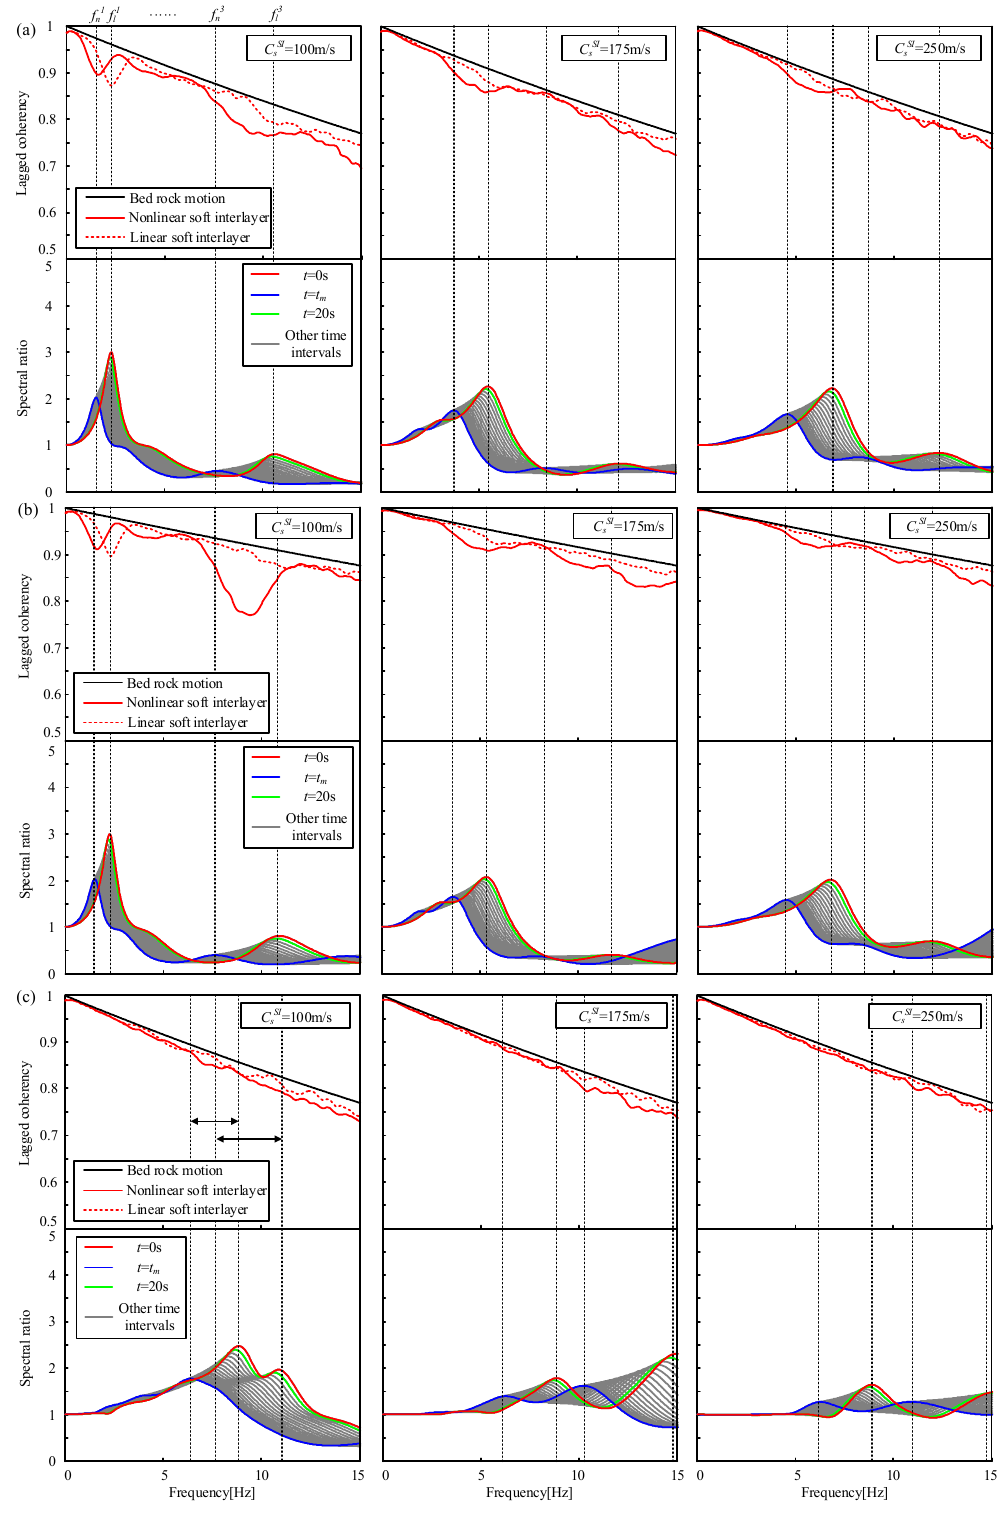
Figure 10. Mean lagged coherency and spectral ratios for ( a ) horizontal out-of-plane motions; ( b ) horizontal in-plane motions; and ( c ) vertical in-plane motions under varying shear wave velocity of soft interlayer.